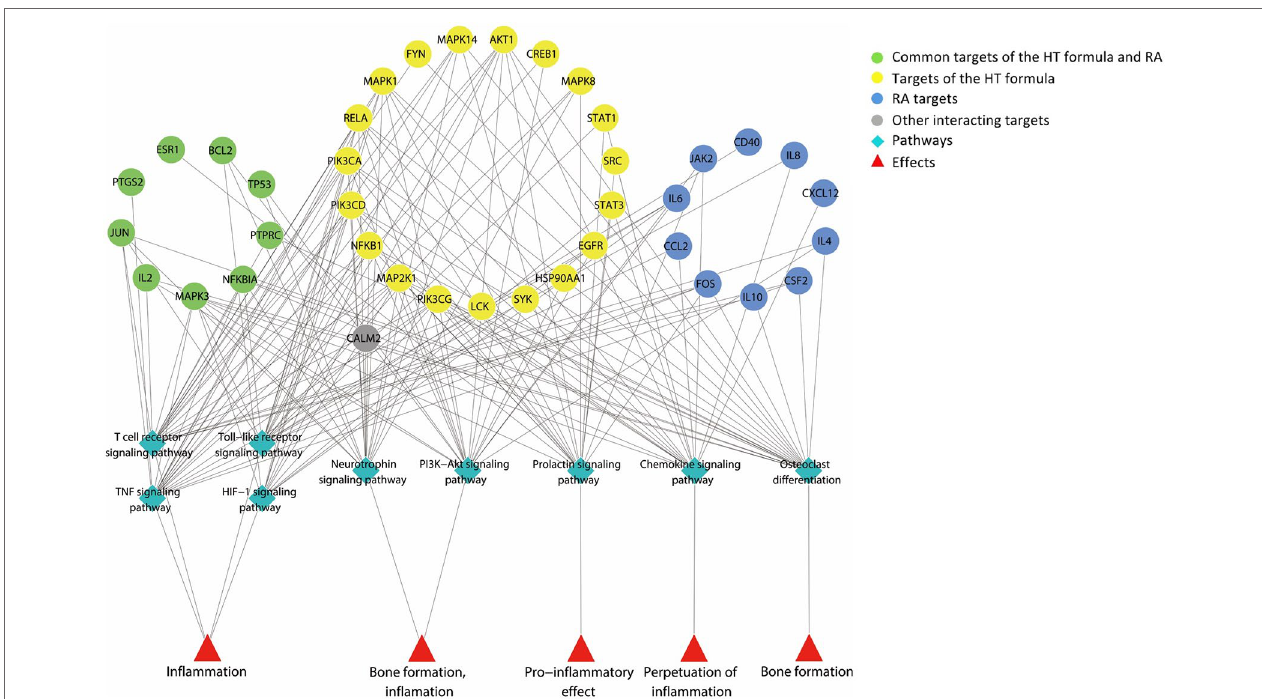
FIGURE 2 | A graph illustrating the major hubs of Huayu-Qiangshen-Tongbi–rheumatoid arthritis (HT–RA) protein–protein interaction (PPI) network and their frequently associated pathways. The pathway enrichment analysis showed that the major hubs were often involved with the nine pathways shown in the graph, and these pathways participated in the bone metabolism and inflammation of